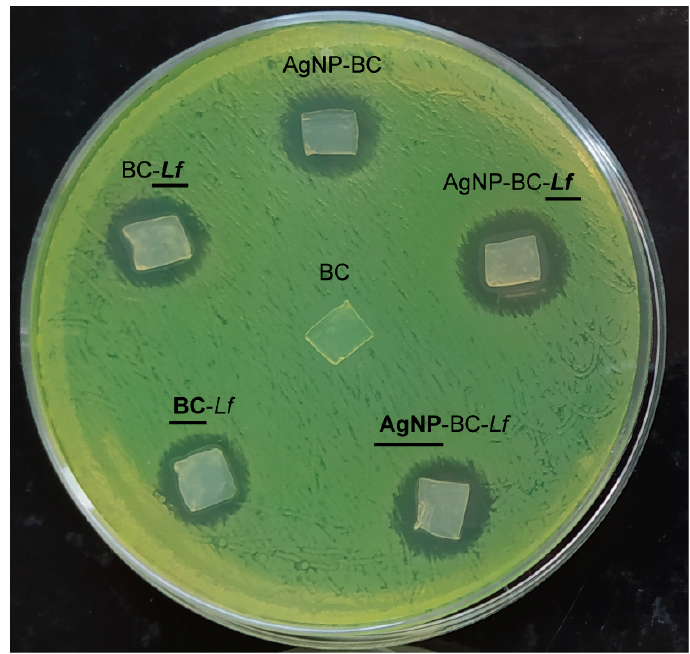
Figure 4. Inhibitory activity of the composite materials against PA . Inhibition zones of BC, AgNP-BC, BC- Lf and AgNP-BC- Lf . The corresponding BC side in contact with agar is marked in bold and underlined. The diameter of the Petri dish is 9 cm.